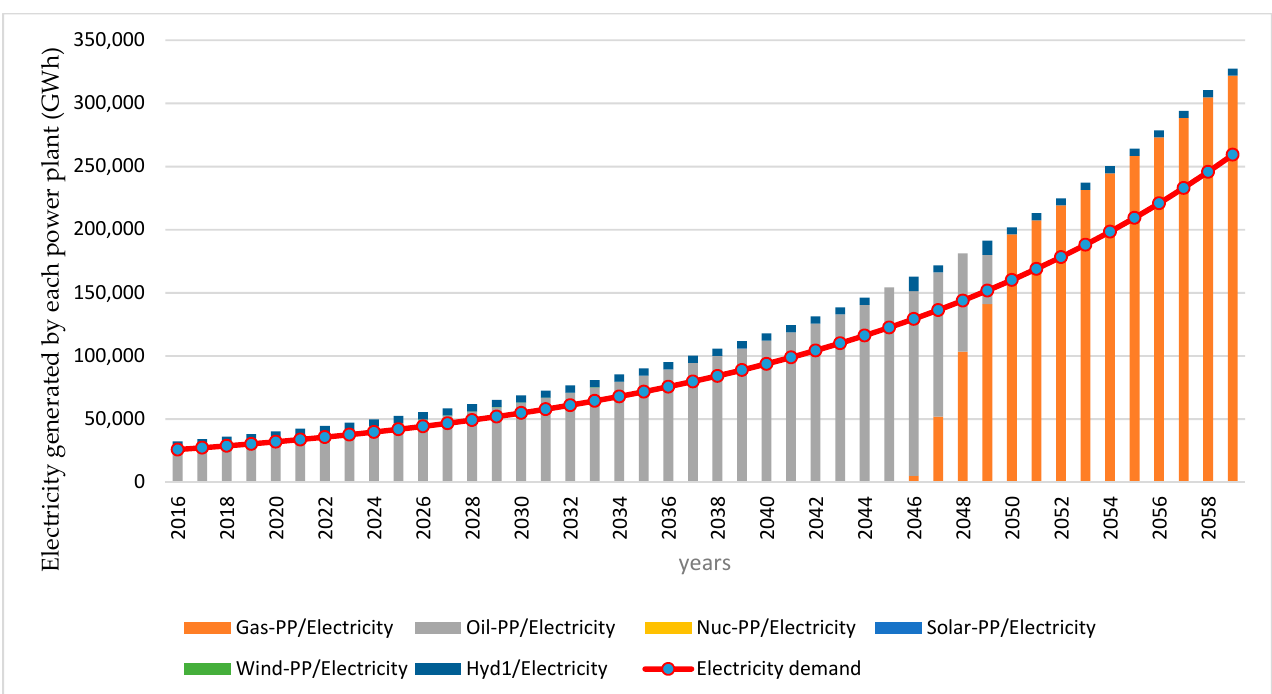
Figure 4. Increase in electricity production and demand from all power plants without a limit on CO 2 emission using MESSAGE code for the modeling period under study.